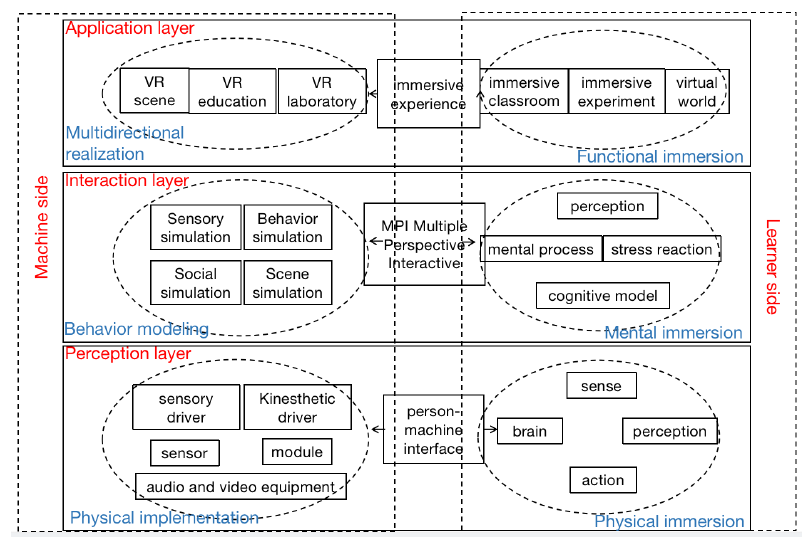
Figure 1. VR-enhanced cognitive learning